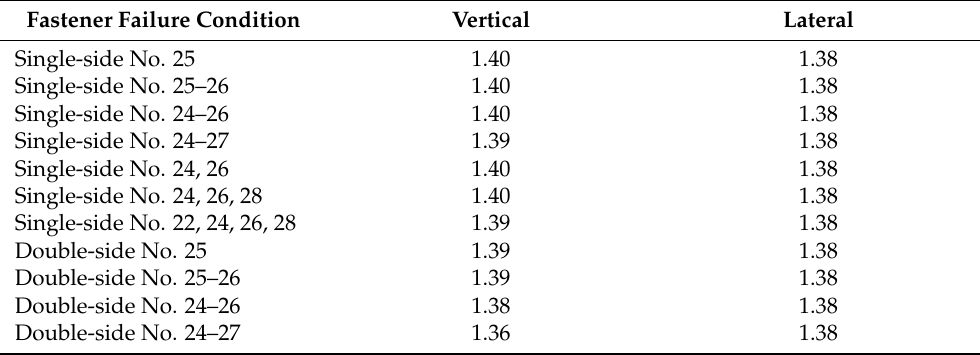
Figure 15. Illustration of three different patterns of failed rail fasteners: ( a ) Single-side consecutive fasteners; ( b ) single-side alternate fasteners; and ( c ) double-side consecutive fasteners. Table 7. The Sperling stability index values of high-speed railway track with single-side and double- side fastener